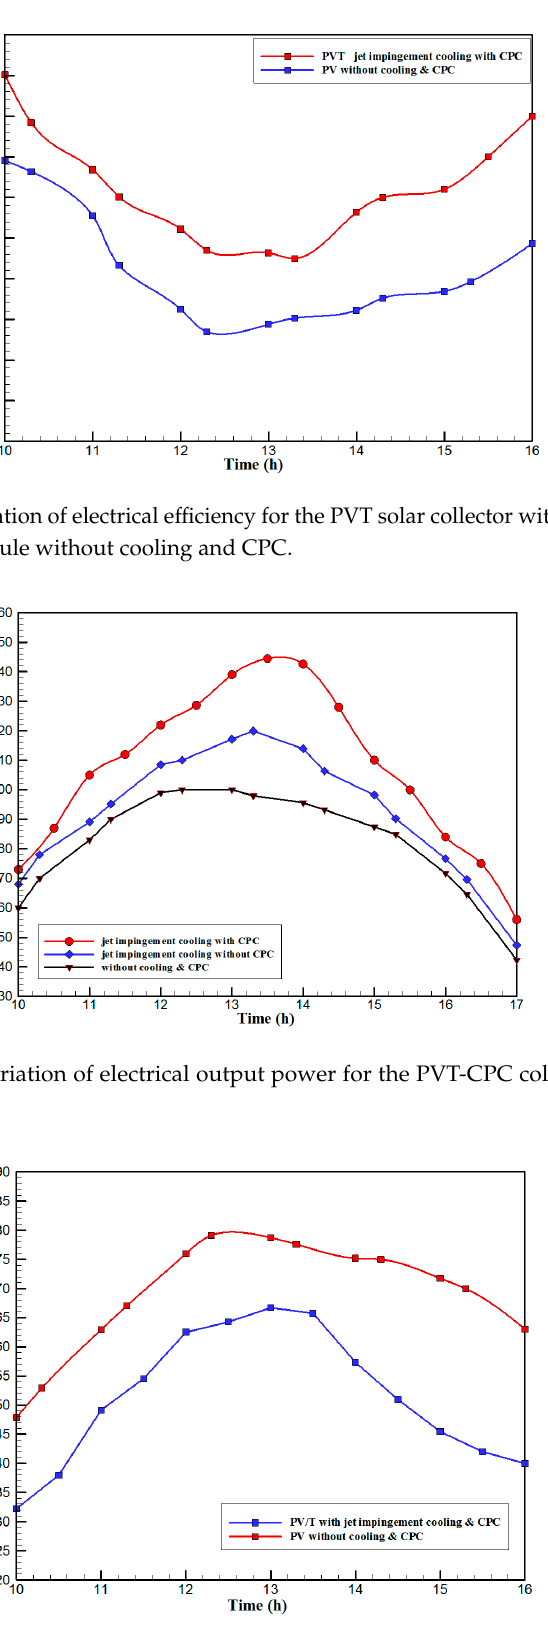
Figure 11. The hourly variation of the PV cell temperature for the PVT solar collector with CPC and the PV module without cooling and CPC.